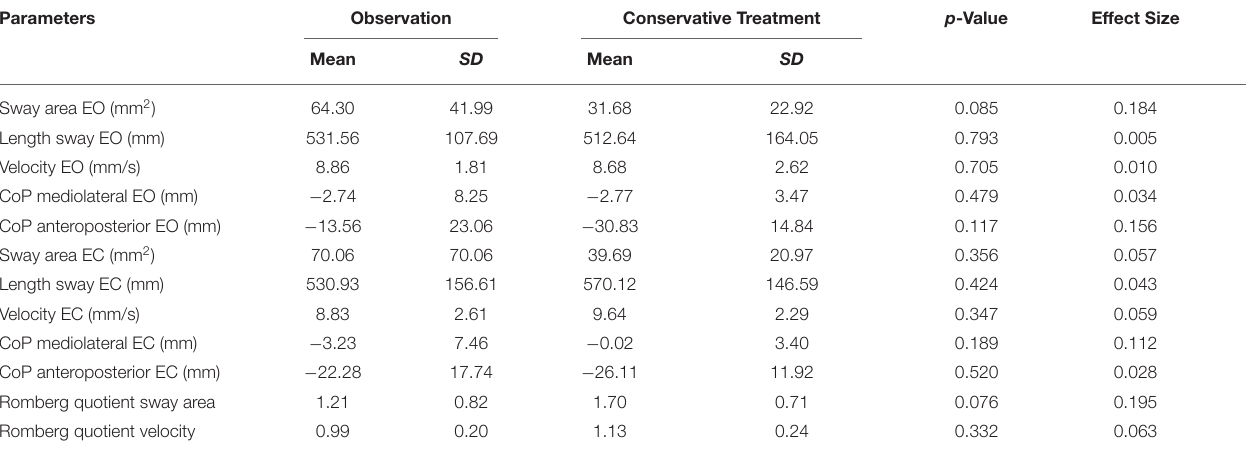
TABLE 3 | Differences in posturographic